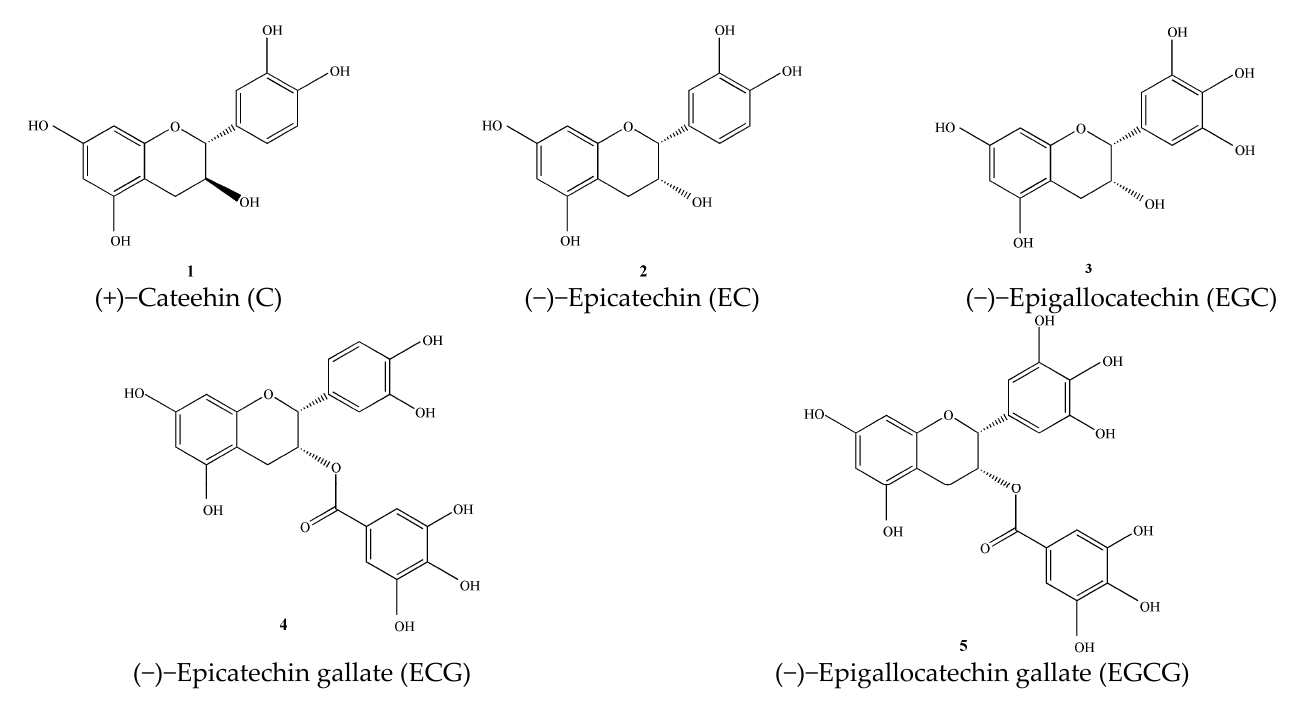
Figure 1. Chemical structures of catechins isolated from green tea.